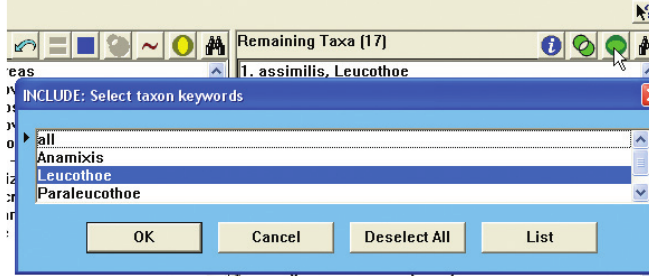
Figure 60. Use a subset of the taxa button.